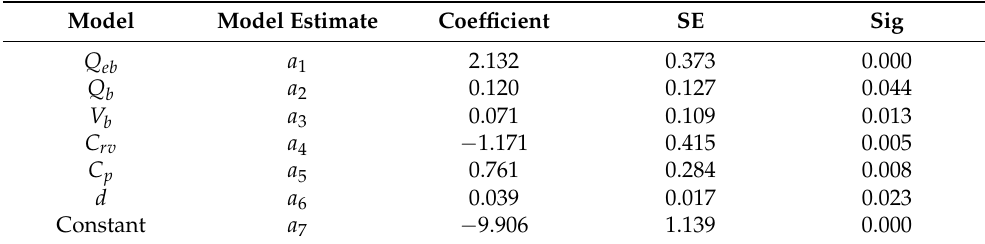
Table 6. Multiple Linear Regression